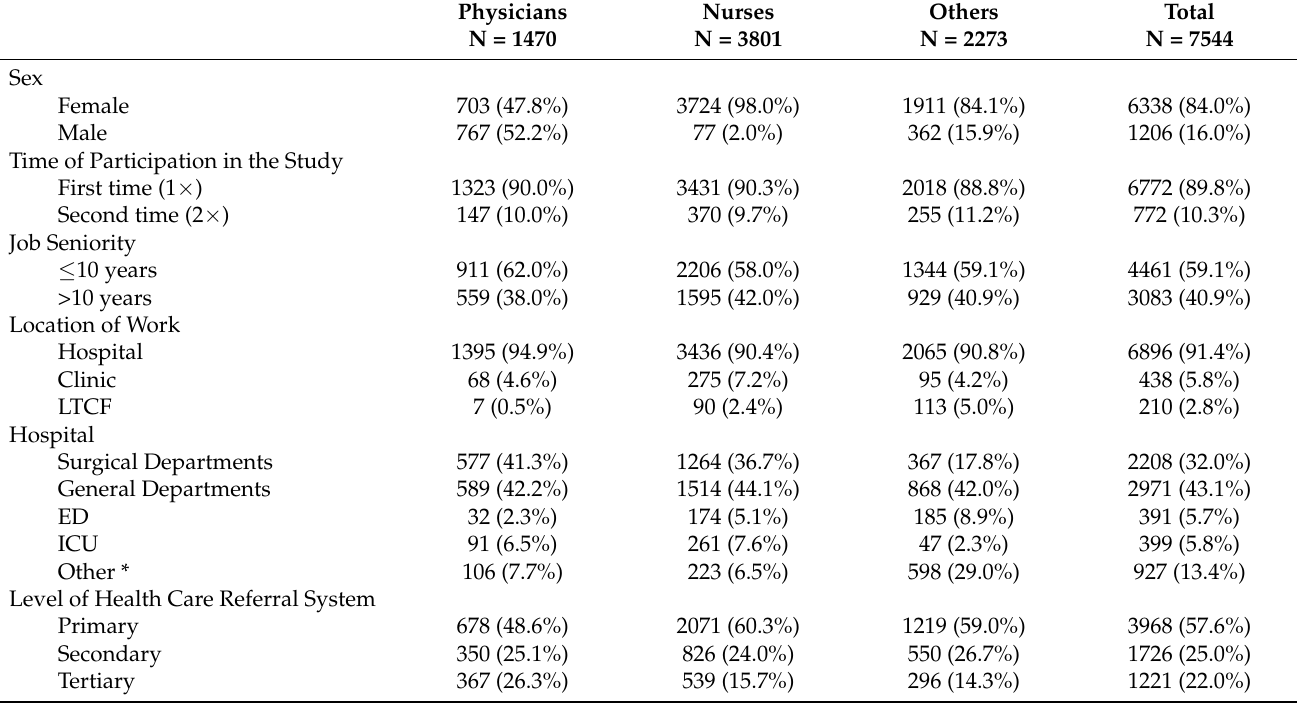
Table 1. Study group